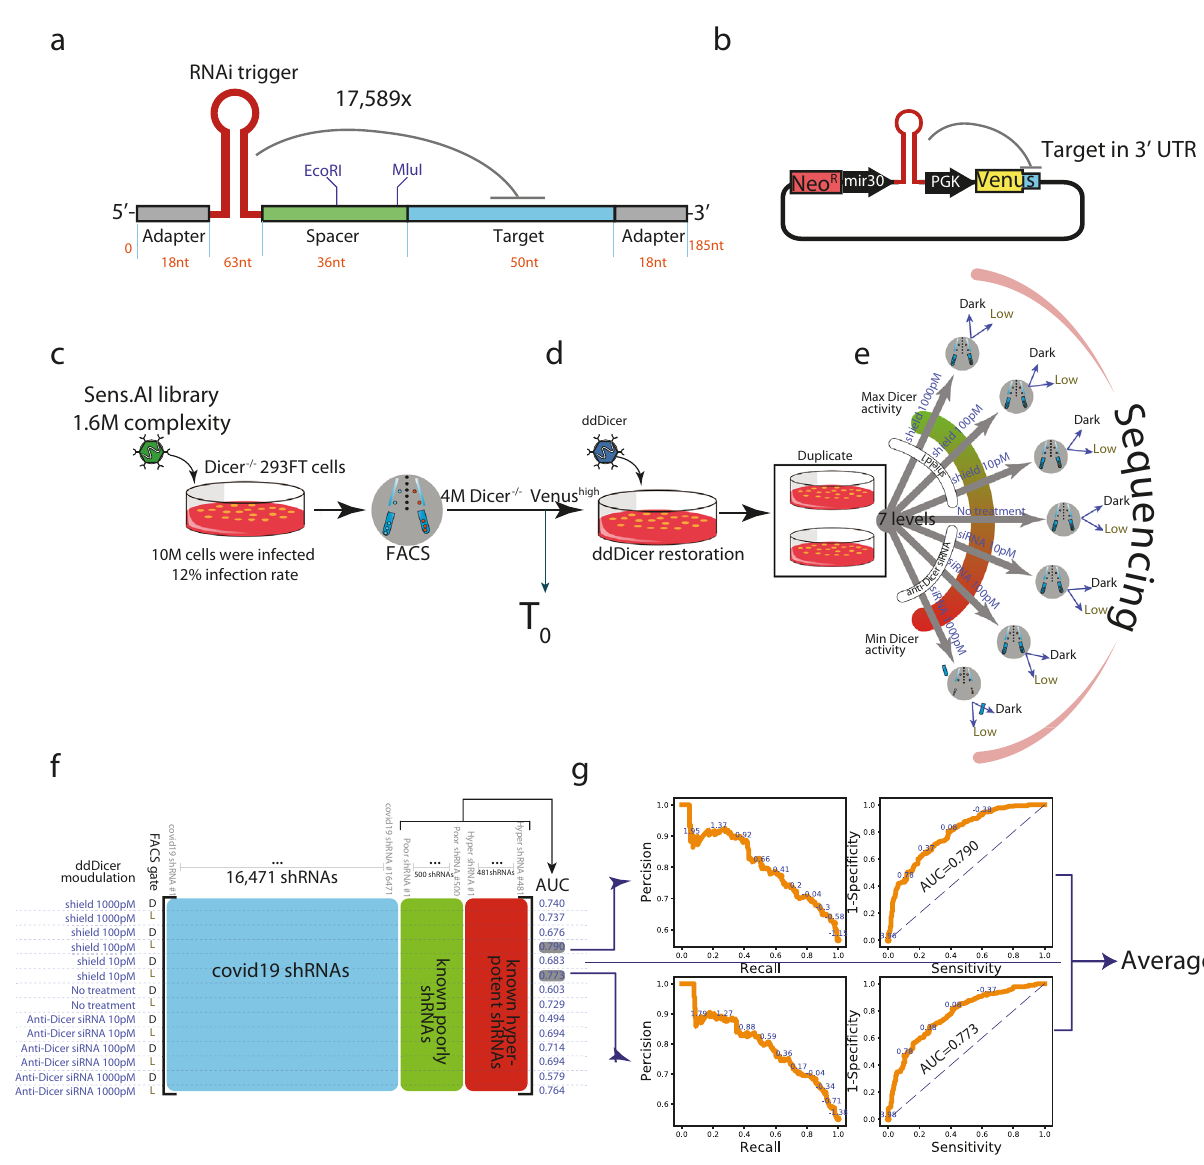
Fig. 1 A genome-wide screen of the SARS-CoV-2 genome by Sens.AI. a Oligo design. Each oligo had a unique RNAi trigger in the context of a miR-30 backbone along with a 50 nucleotide stretch fl anking the viral RNAi target site; b Library design. Each plasmid contained a speci fi c RNAi trigger and its matching target site in cis as part of the 3 ’ UTR of a Venus reporter; c – e Scheme of an in vitro screen in human cells: c The RNAi machinery was fi rst turned off. Dicer − / − 293FT cells were infected with the plasmid library and sorted for Venus high expression, which formed the T 0 read out; d The RNAi machinery was then turned on. We restored the RNAi machinery by ectopic expression of a destabilised Dicer (ddDicer); e The activity of the RNAi machinery was modulated quantitatively. Two biological replicates were subjected to seven different conditions, designed to titer Dicer expression either downward, by treatment with an anti-Dicer siRNA, or upwards, by treatment with Shield-1. Upon FACS sorting, Venus low and Venus dark cells were collected, and their oligo constructs regions were sequenced; f The resulting data matrix of the screen. Each row represents a speci fi c combination of a treatment condition (the far left column) and a FACS gate (denoted as D, for Dark, and L, for Low). These row vectors describe the enrichment of each tested RNAi trigger (blue) compared to negative (green highlighted) and positive (red highlighted) controls. The area under the curve (AUC) column was calculated based on the ability to distinguish the positive from the negative controls; g Selection of the two best conditions. The two-row vectors with the highest AUC were selected. Precision-recall (left) and receiver operating characteristics (right) curves calculated for the intrinsic controls are shown. The screen score of each RNAi trigger was calculated as the average of these two-row